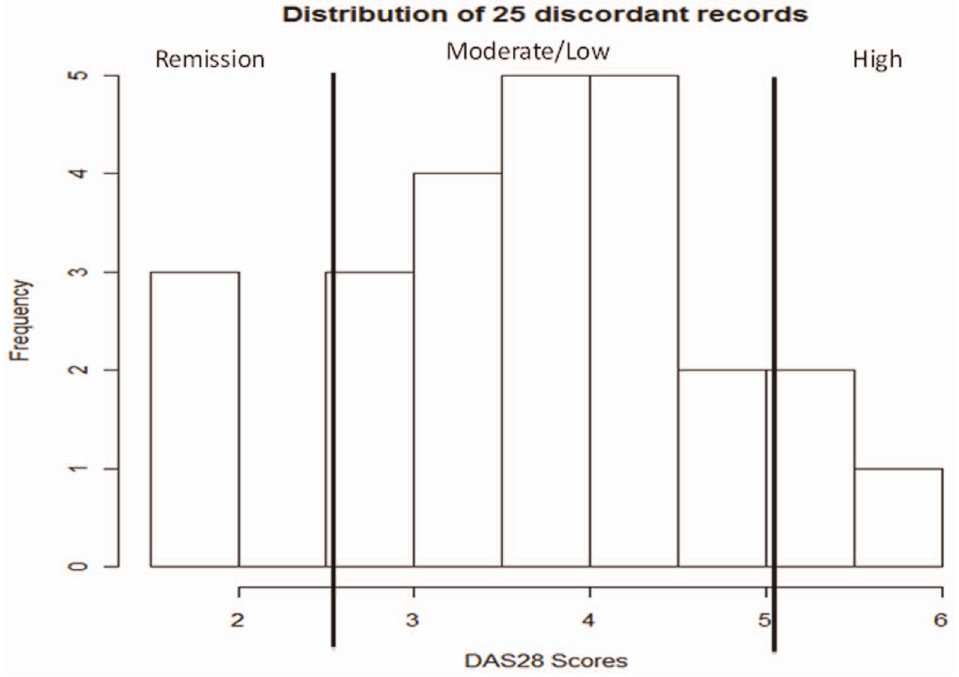
Figure 3. Histogram of DAS28 scores for 25 discordant cases. These discordant cases are between DAS labels and domain expert labels among 93 random samples from the Training Set (the remaining 68 cases were concordant). doi:10.1371/journal.pone.0069932.g003 between DAS28 and log transformed lab values appears random (Figure 5, right diagram, Spearman: 0.02 [49]). For the 1320 correctly classified cases, the scatter plot (Figure 5, left diagram) shows relatively good correlation (Spearman: 0.63).